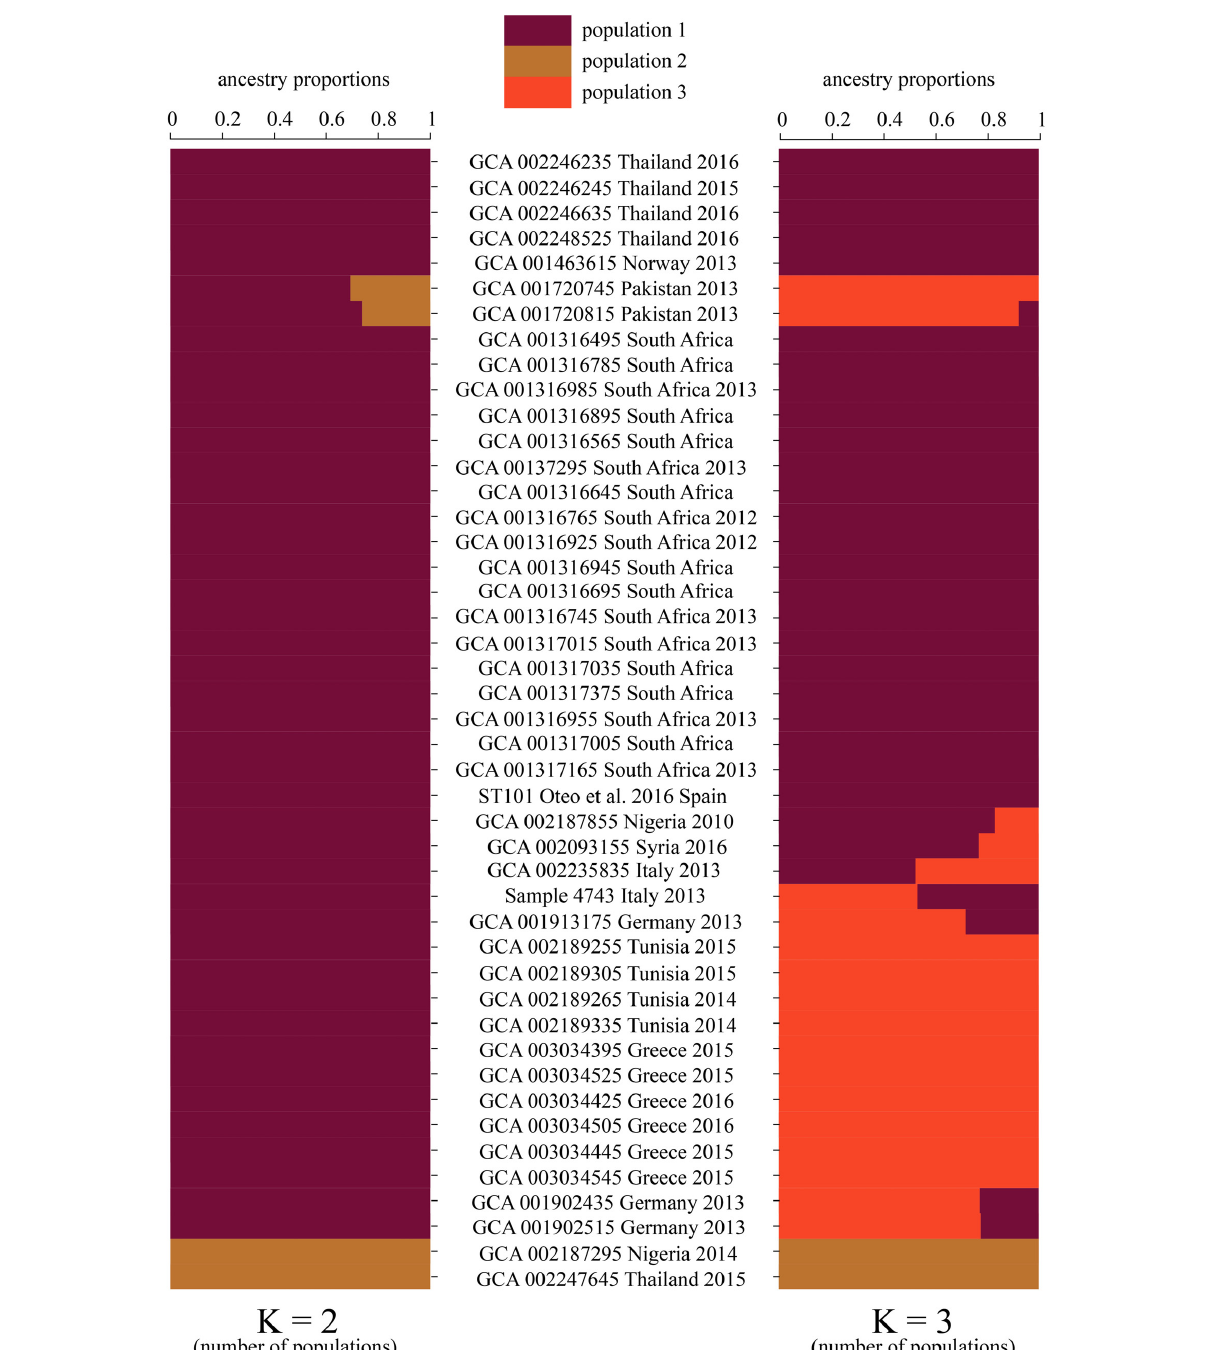
yersiniabactin on the mobile genetic element ICE Kp3 except for two samples, GCA 002187295 and GCA 002247645, which fall outside the main ST101 clade ( Figure 1 ). The ST101